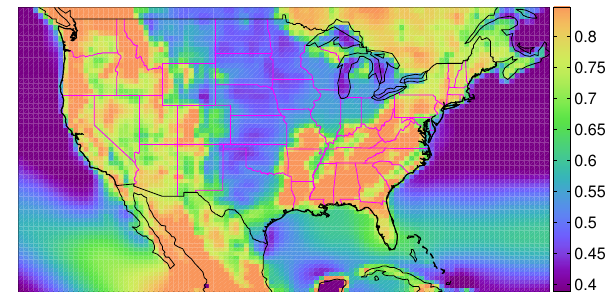
Fig. 5. Unavailability of WPD across the